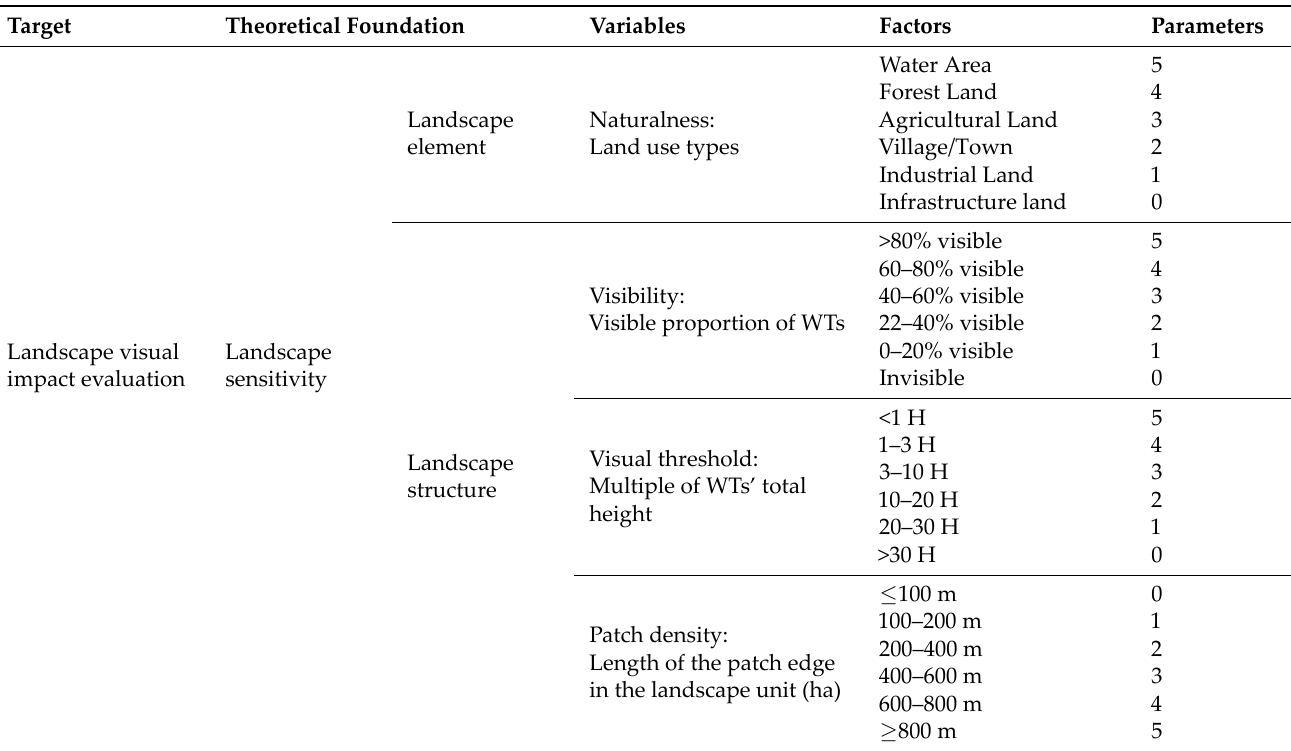
Table 2. Indicator set of landscape visual impact